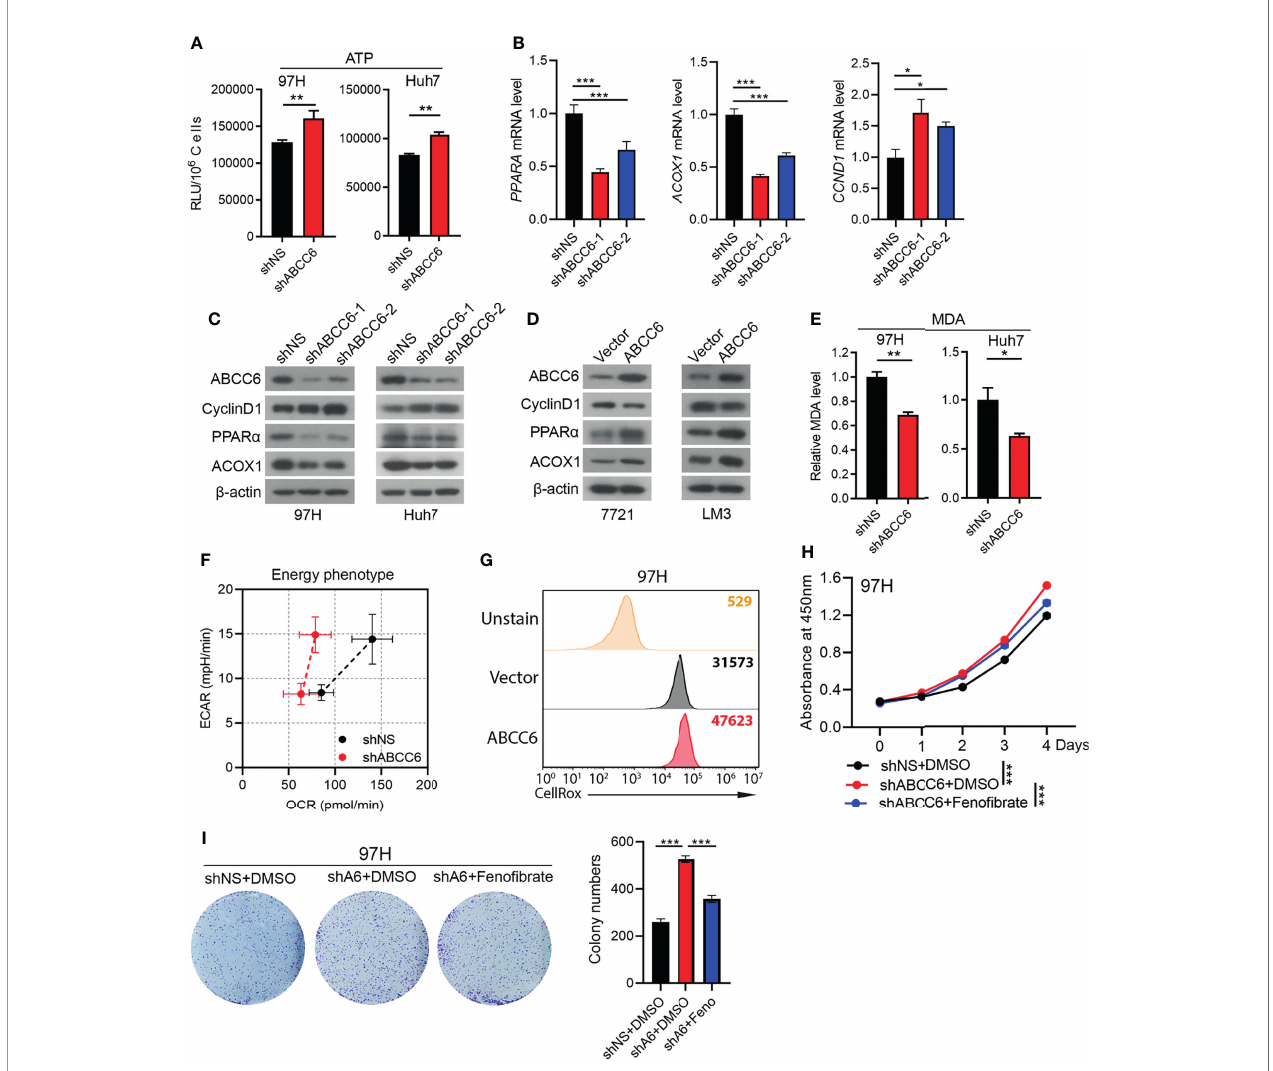
FIGURE 7 | ABCC6 knockdown suppressed PPAR a expression in HCC cells. (A) ATP level of ABCC6 knockdown and control 97H and Huh7 cells. (B) qPCR analysis showing the expression of PPARA , ACOX1 and CCND1 in ABCC6 knockdown 97H cells. (C) Western blot showing the protein levels of ABCC6, Cyclin D1, PPAR a and ACOX1 in ABCC6 knockdown 97H and Huh7 cells. (D) Western blot showing the protein levels of ABCC6, Cyclin D1, PPAR a and ACOX1 in ABCC6 overexpression 7721 and LM3 cells. (E) MDA assay showing the relative lipid peroxidation level of ABCC6 knockdown and control 97H and Huh7 cells. (F) Seahorse assay displaying the baseline and stressed energy phenotype of ABCC6 knockdown and control 97H cells. (G) Flow cytometry analysis showing the intracellular ROS level of vector and ABCC6 overexpression 97H cells. (H) CCK-8 assay showing the effect of PPAR a agonist feno fi brate in the proliferation of ABCC6 knockdown and control 97H cells. (I) Colony formation assay showing the effect of PPAR a agonist feno fi brate in the proliferation of ABCC6 knockdown and control 97H cells. Error bars indicate means ± SEM. P -values were determined by two tailed t -test (A, E) and one-way ANOVA (B, H, I) . * P < 0.05, ** P < 0.01, *** P <